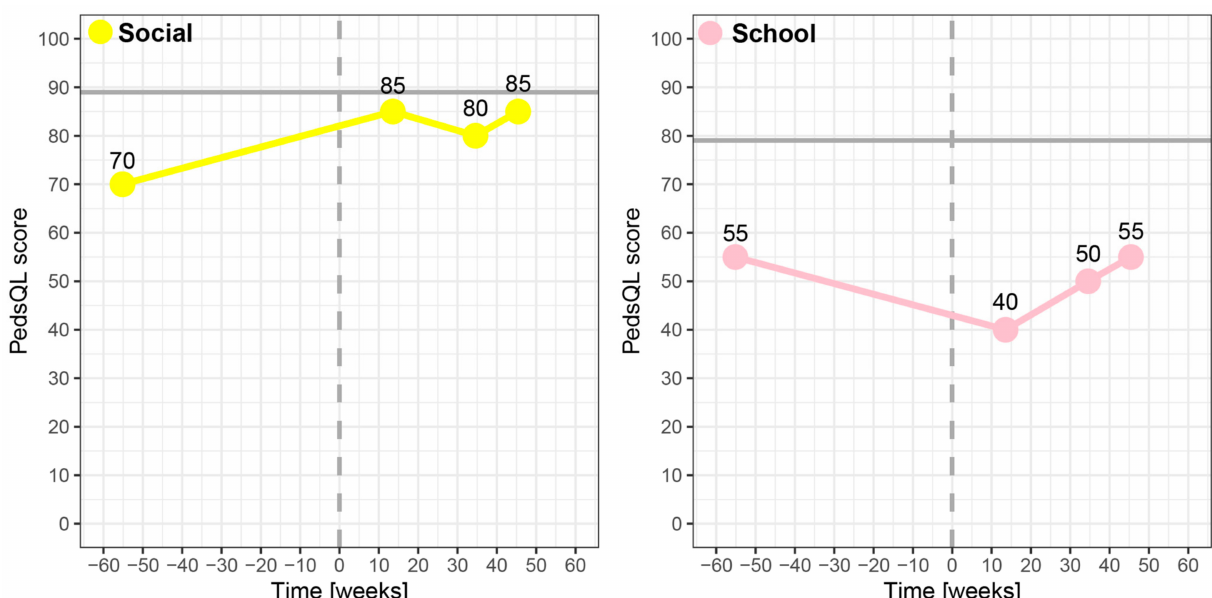
Figure 4. Visual graph of a kidney transplant patient whose overall HRQoL, measured with the PedsQL, improved following transplantation (vertical dashed line), but would still be below the overall mean score of the reference group (horizontal solid line). Before transplantation, this patient was